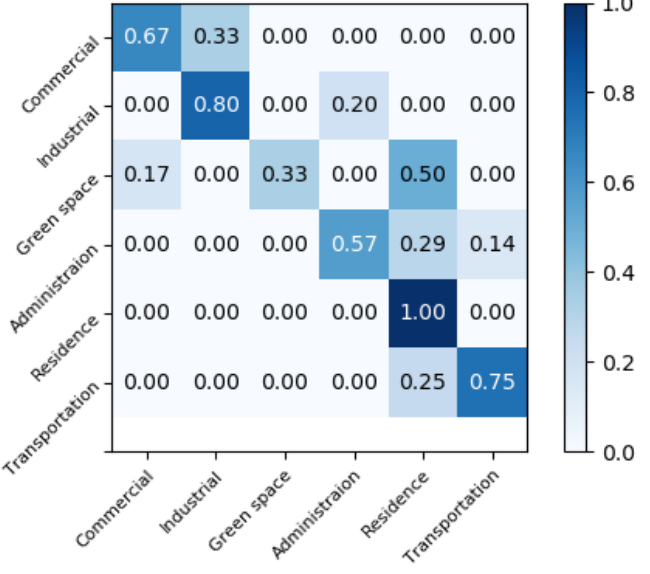
Figure 13. The confusion matrix of the identifying results based on POI